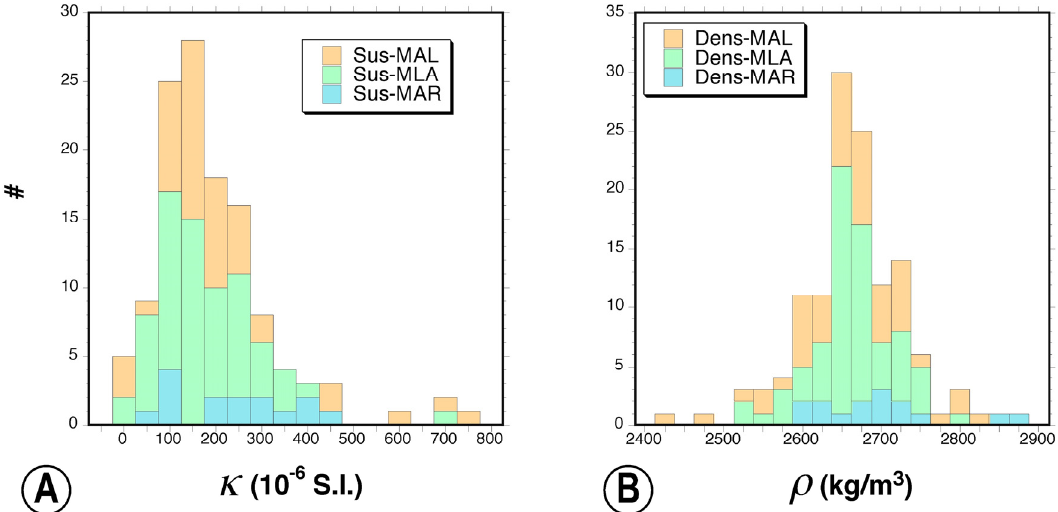
Figure 6. Magnetic susceptibility ( A ) and density histograms ( B ) of the studied samples (only site mean values were used). The three plutons are plotted with different colors Maladeta (orange), Marimanha (blue), Mont-Louis-Andorra (green). Ordinates (#) represent the number of data.